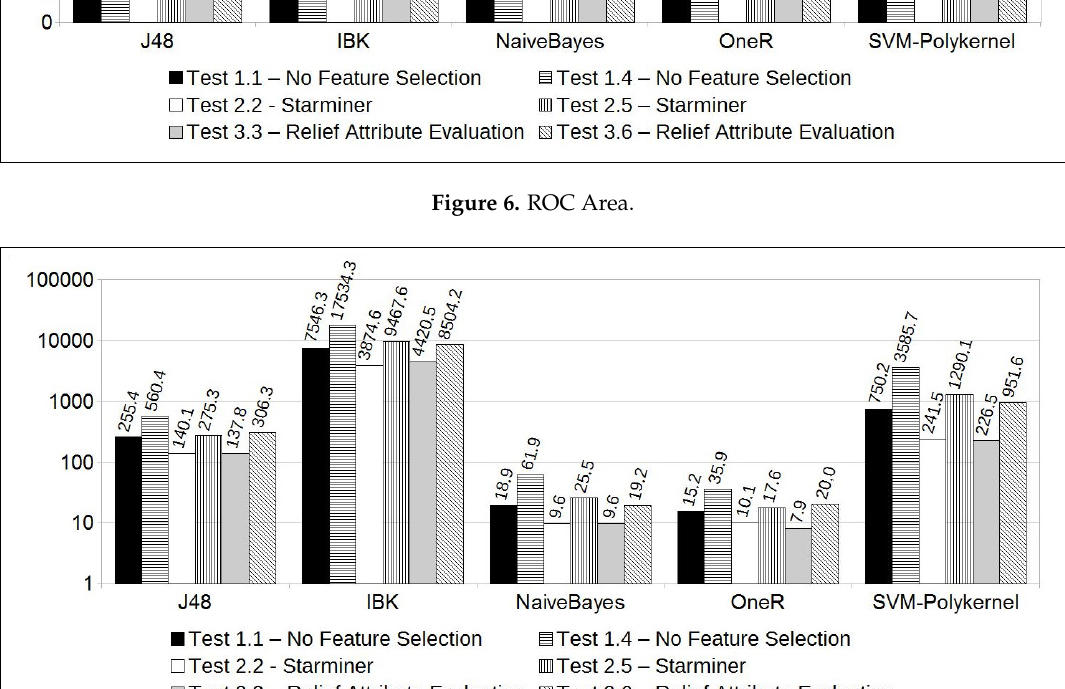
Figure 7. Total time = Training Time + Testing Time (Time in